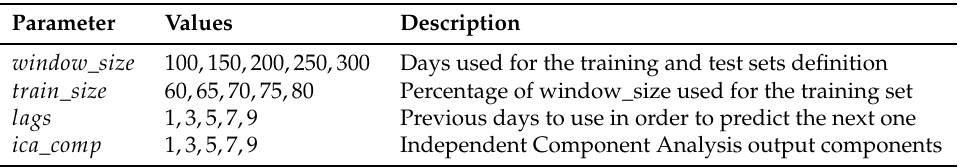
Table 3. Hyper-parameters